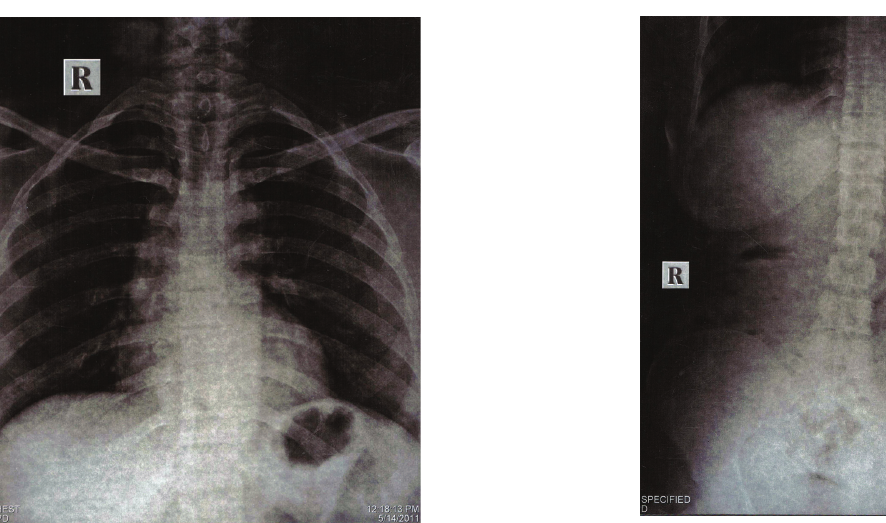
Figure 1: Chest radiograph after half an hour, showing no evidence of instrument.